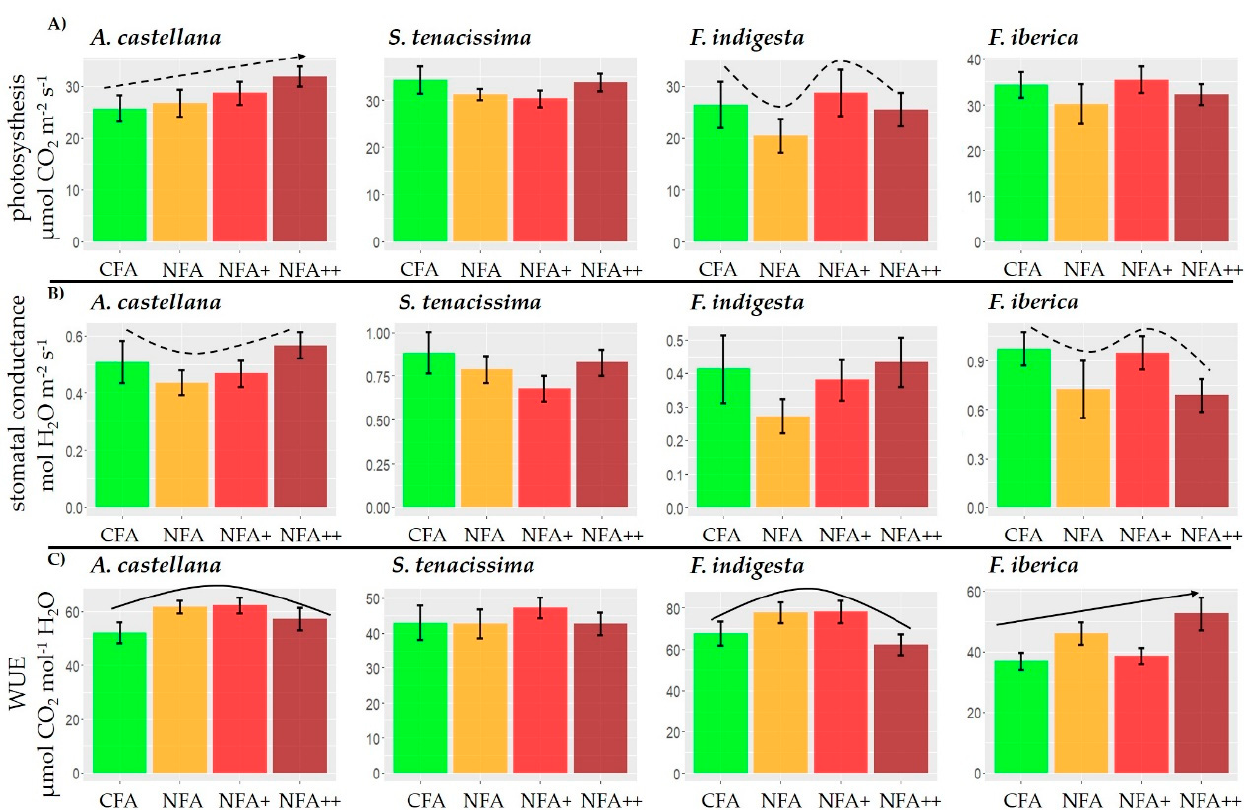
Figure 2. Ozone effect on gas exchange parameters: photosynthesis (A, μ mol CO 2 m − 2 s − 1 ) ( A ), stomatal conductance (g s , mol H 2 O m − 2 s − 1 ), ( B ) and water use efficiency (WUE, μ mol CO 2 mol − 1 H 2 O) ( C ) for A. castellana , S. tenaccissima , F. indigesta , and F. iberica . Bars denote mean ± SE. O 3 treatments: charcoal-filtered air (CFA), non-filtered air (NFA), non-filtered air + 20nL L − 1 of O 3 (NFA+), and non- filtered air + 40nL L − 1 of O 3 (NFA ++) treatments. Solid and dotted lines denote significant and marginally significant trends, respectively.